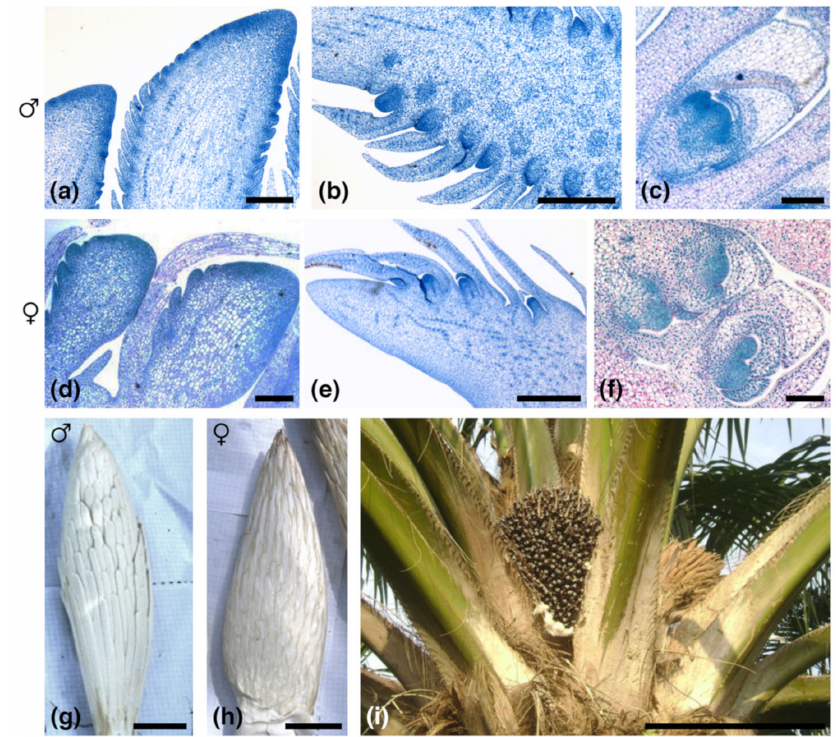
Figure 1. Stages of oil palm inflorescence development; microscopic views in panels ( a – f ) and macro- scopic views in panels ( g – i ). ( a ) Longitudinal section of male rachilla (leaf +5) showing young floral bracts; ( b ) Longitudinal section of male rachilla (leaf +12) showing flower primordia; ( c ) Longitudinal section of male rachilla (leaf +15) showing early differentiating male flower; ( d ) Longitudinal section of female rachilla (leaf 0) showing floral triad bracts; ( e ) Longitudinal section of female rachilla (leaf +10) showing floral triad initiation; ( f ) Longitudinal section of female rachilla (leaf +14) show- ing floral triad development; ( g ) Nearly mature male inflorescence (leaf +17); ( h ) nearly mature female inflorescence (leaf +16); ( i ) crown of adult palm showing infructescence and senescent male inflorescence. Scale bars: ( a , c , d , f ), 0.1 mm; ( b ), 0.5 mm; ( e ), 1 mm; ( g , h ), 5 cm; ( i ), 50